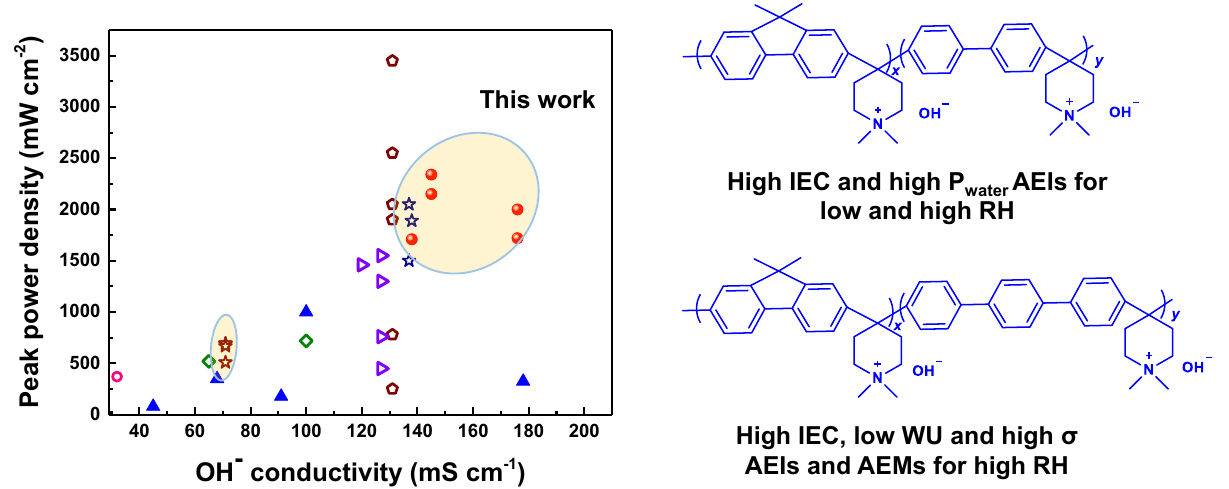
Fig. 5 Comparison of representative AEIs in current research in regard to OH − conductivity and PPDs at 80 °C. PFAP (red cycle) and FAA Fumion ionomers (brown star) in this work. PSF/PPO ionomers (blue triangle symbols): BMTA-polysulfone 49 , BTMA-PPO 11 , DMP-PPO, ASU-PPO 26 , and multi- cation side chain PPO 50 . PBI ionomers (pink circle symbols): HMT-PBI 26 ; BTMA-ETFE ionomers (brown pentagon symbols) 12,15,29 – 31,33 . BTMA-SEBS ionomers (green tetragon symbols) 51,52 , PAP ionomers (blue star symbols): PFTP-0 and PFBP-0 ionomers 17,32,36 , but the OH − conductivity of PFBP-0 is currently missing. PF/PP ionomers (purple triangle symbols): side-chain poly fl uorene and polyphenylene 34,37 .